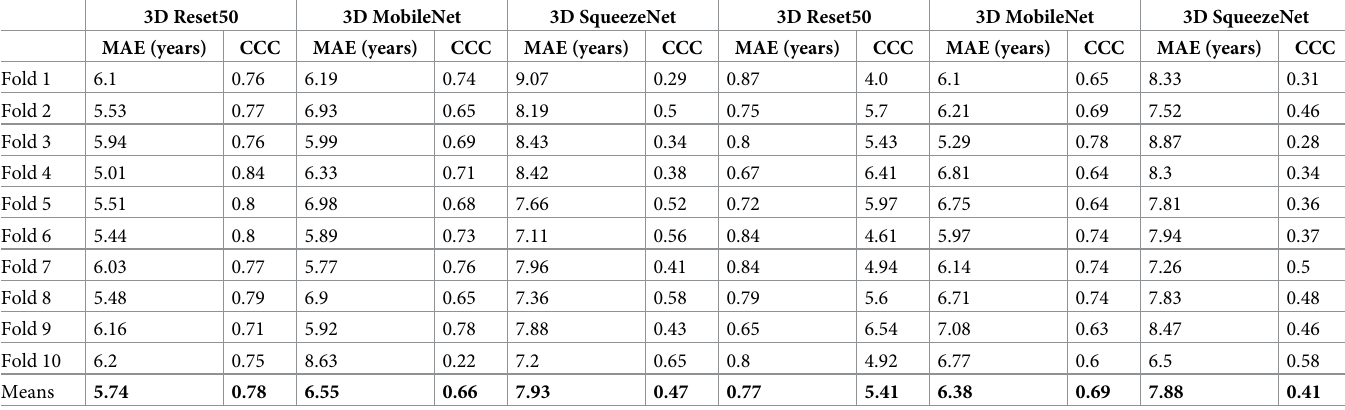
Table 4. Comparing age estimation results using SqueezeNet, MobileNet, and Resnet models for extracting femur features. 3D